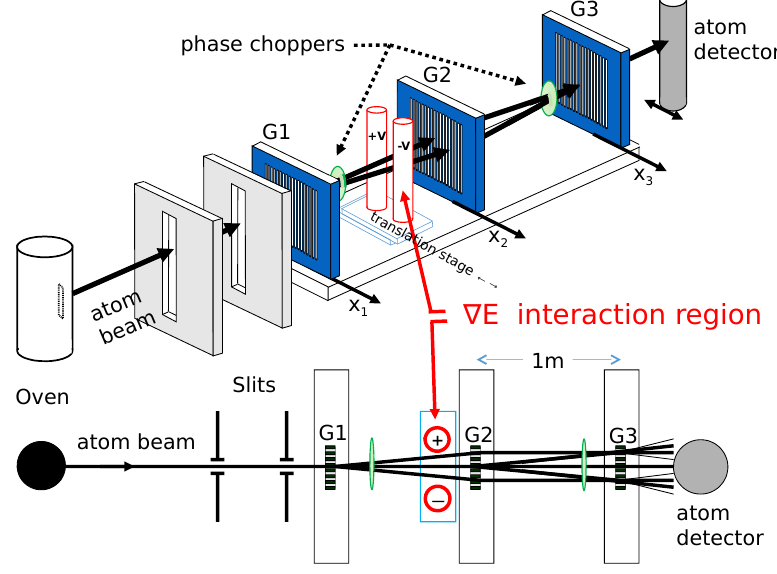
Figure 2. Diagram of the atom interferometer we used to measure the static polarizabilities of K, Rb, and Cs [3]. A pair of cylindrical, oppositely-charged electrodes, indicated in red , induce phase shifts that depend on atoms’ polarizabilities and the gradient of the produced electric